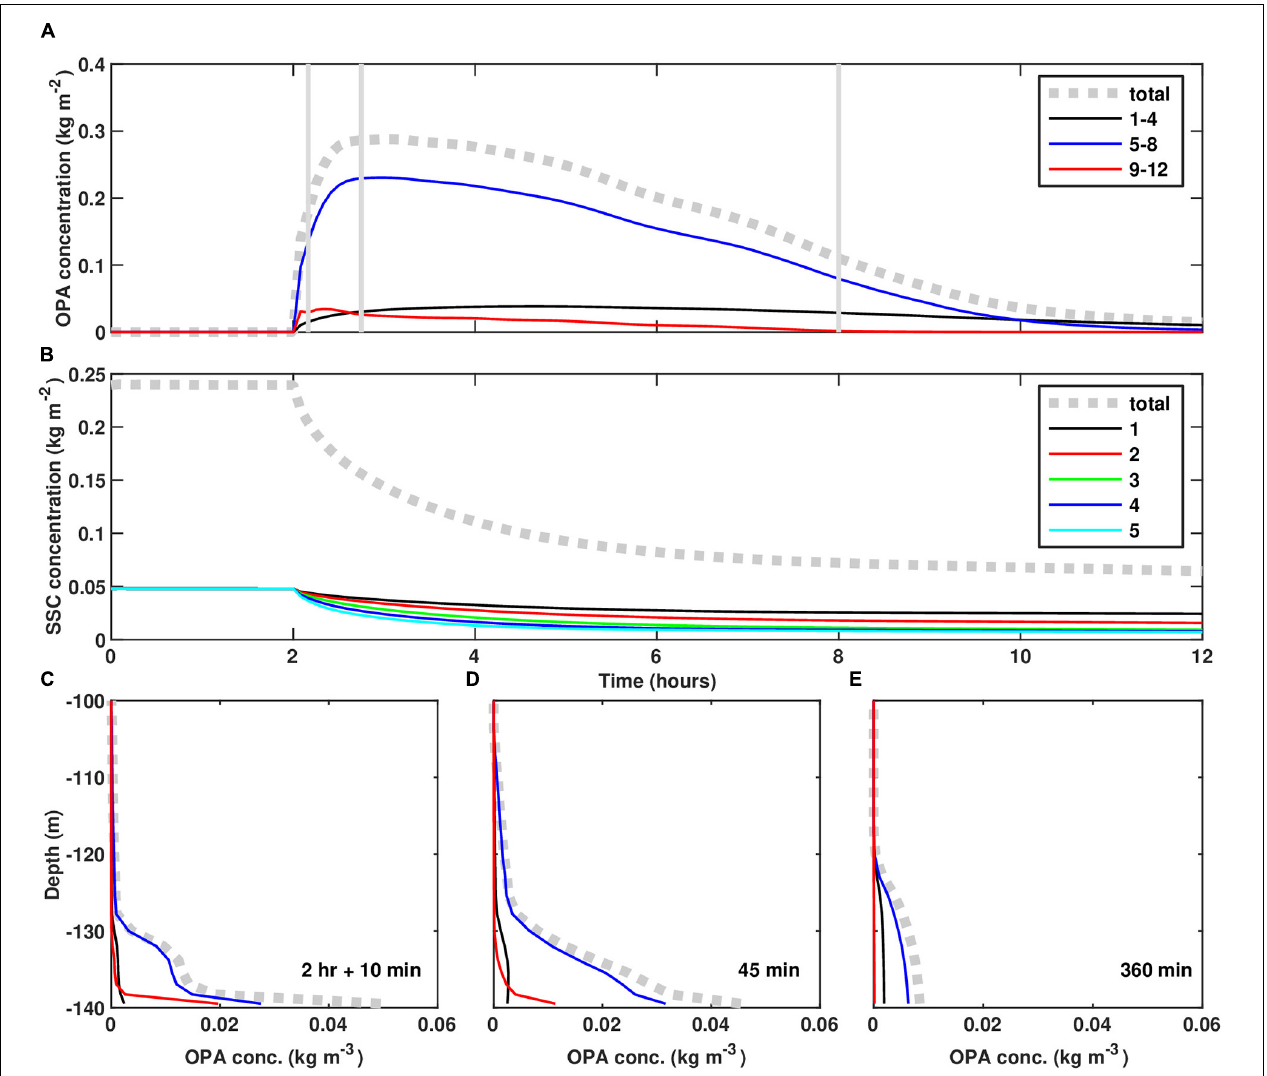
FIGURE 7 | Time-series for the hurricane scenario of depth-integrated (A) OPA mass concentration and (B) SSC mass concentration. Profiles of OPA mass concentration at (C) 10 min, (D) 25 min, and (E) 360 min after activating OPAMOD, respectively. Lines in panels (C–E) share the same legend shown in panel (A) , with dotted gray line representing the total OPA size classes, black line representing the OPA size classes from 1 to 4, blue line representing the OPA size classes from 5 to 8, and red line representing the OPA size classes from 9 to 12, respectively.